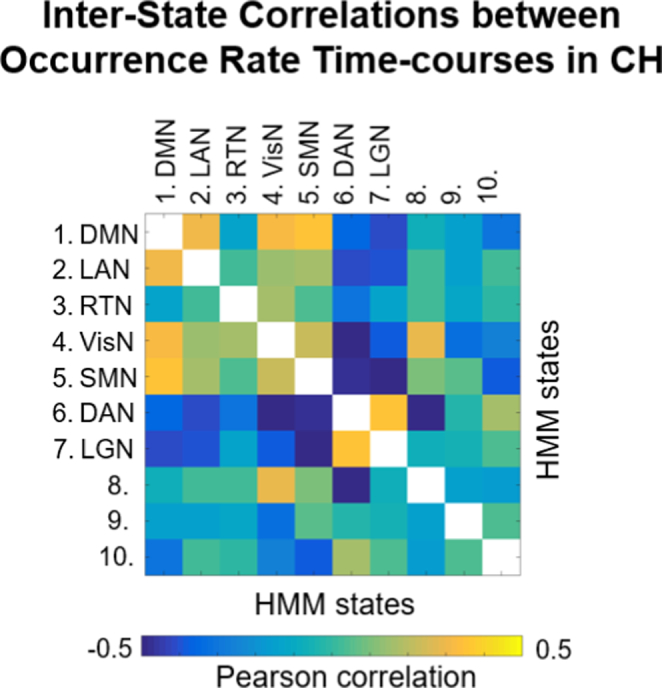
Temporal relationships between visits to different HMM states. Fluctuations in the rate of occurrence of each HMM state over time were quantified as changes in the proportion of time spent in the state within 10-sec-long (following Baker et al., 2014) sliding windows. Shown are Pearson correlations between the occurrence rate time-courses in each pair of states. This pattern of inter-state temporal relationships is similar to that in prior HMM on MEG data (Baker et al., 2014). Abbreviations are the same as in Fig. 2.